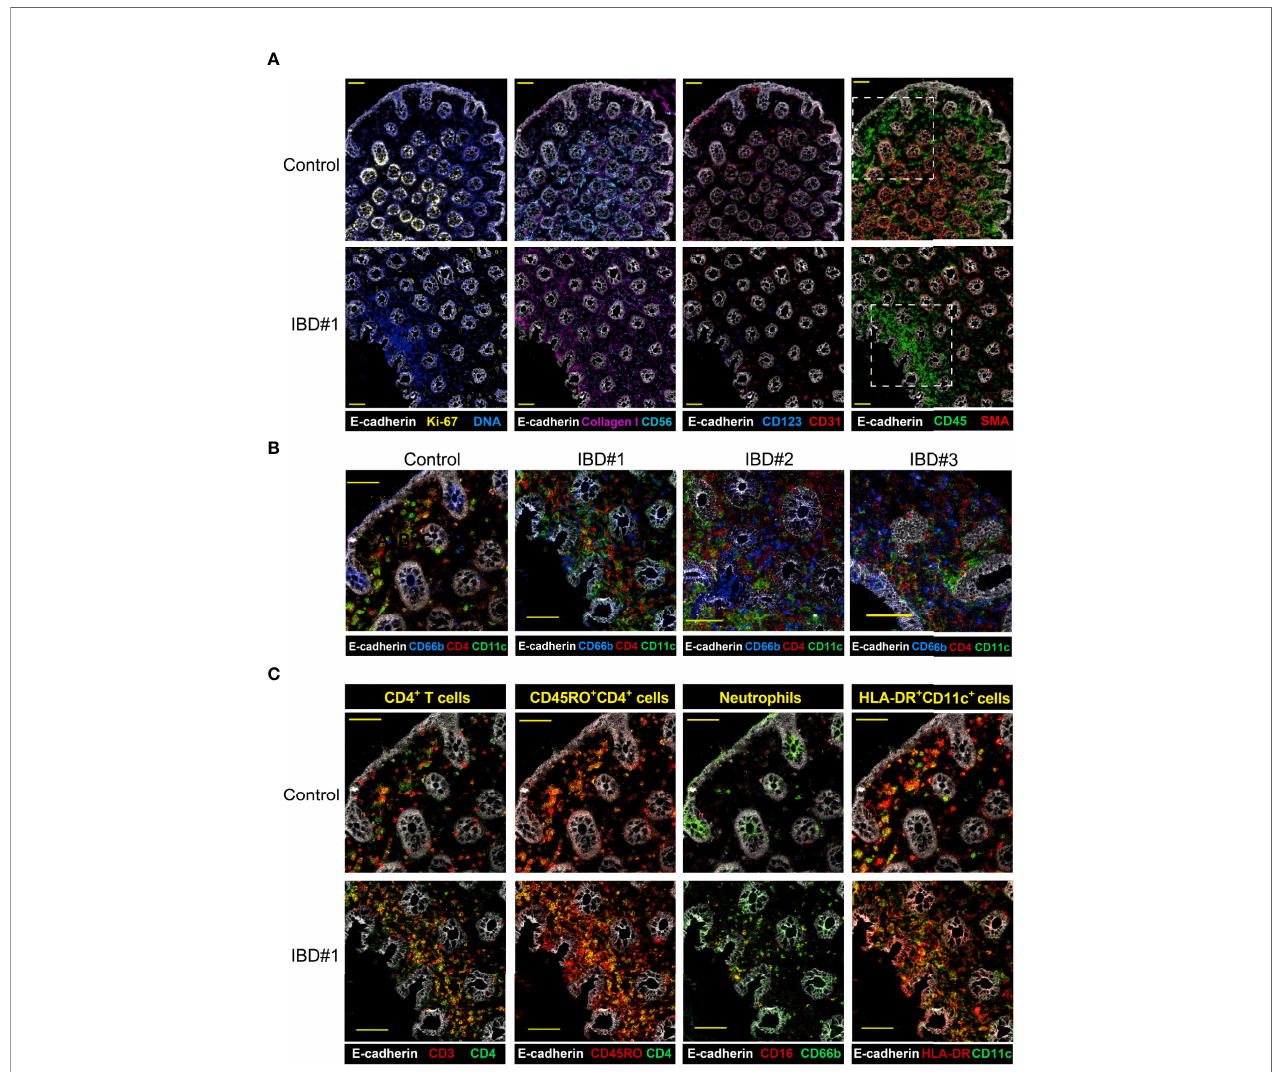
FIGURE 6 | Imaging-mass cytometry reveals immune cell aggregates in the in fl amed intestine. Representive images (A) structural markers (E-cadherin, Ki67, DNA, Collagen I, CD56, CD31, SMA) and CD45 expression are depicted for IBD biopsies from a control and three IBD patients, yellow scale bar: 100 m m. (B) Major immune lineage markers (CD4, CD11c) together with E-cadherin present in a region of a control and three IBD biopsies (dotted line in panel (A) , yellow scale bar: 50 m m. (C) Co-expresion of CD3 and CD45RO with CD4, CD16 with CD66b, and HLA-DR with CD11c in the same region highlighted in panel (A) for a control and an IBD patient biopsy; scale bar: 50 m